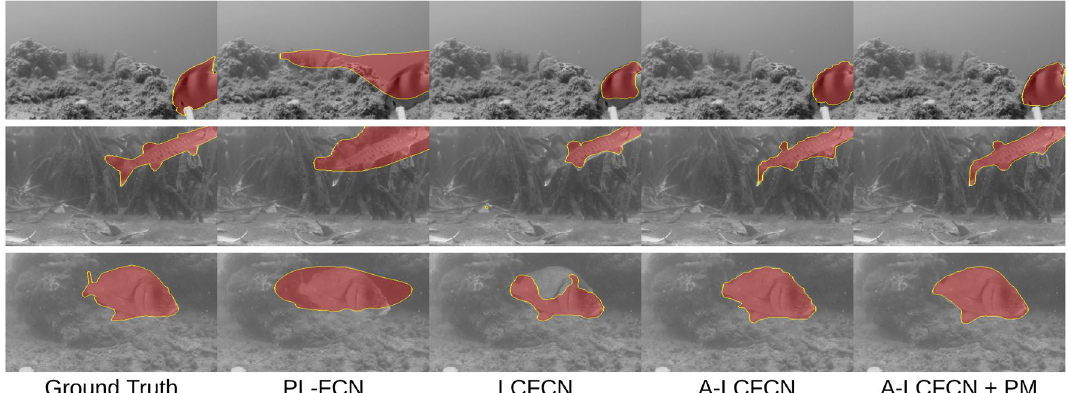
Figure 4. Qualitative results. Predictions obtained from training point-level FCN (PL-FCN), LCFCN, affinity LCFCN (A-LCFCN) and A-LCFCN with pseudo-masks (A-LCFCN + PM). Each row corresponds to a different sample. With the affinity branch the predictions are much closer to the ground-truth